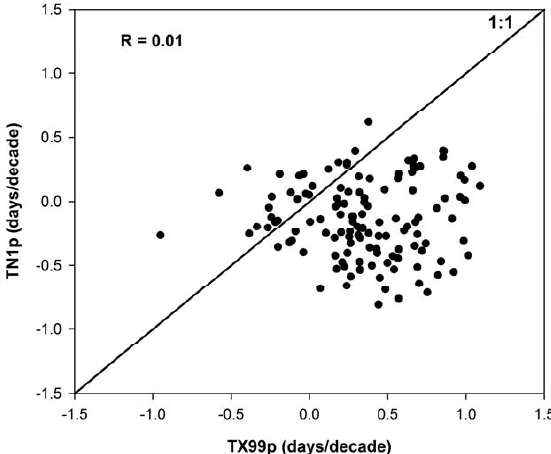
Figure 13: Scatter plot of the relationship between the observed trends in TX99p and Fig. 13. Scatter plot of the relationship between the observed trends TN1p. in TX99p and